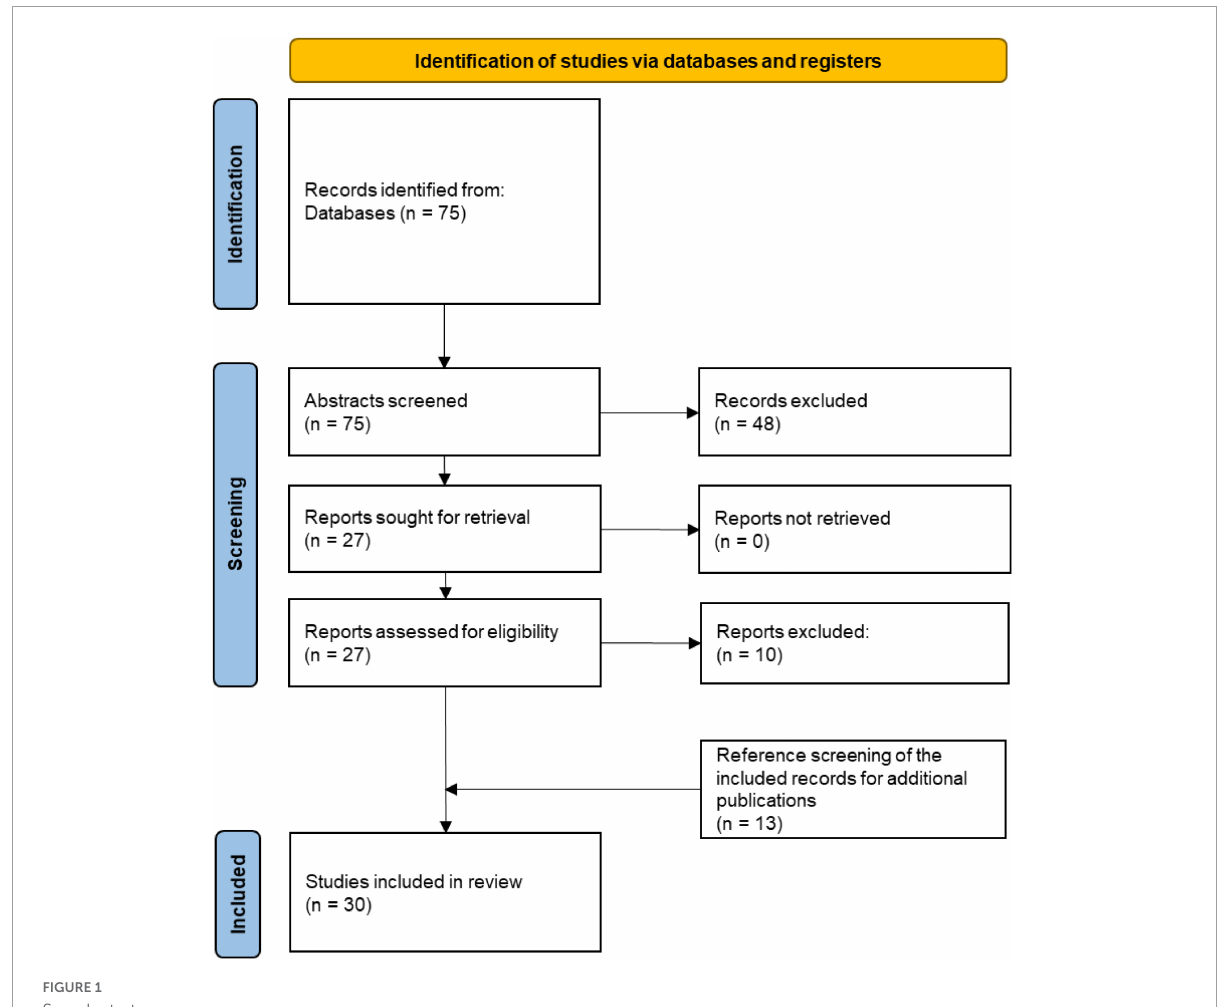
FIGURE1 Search strategy.